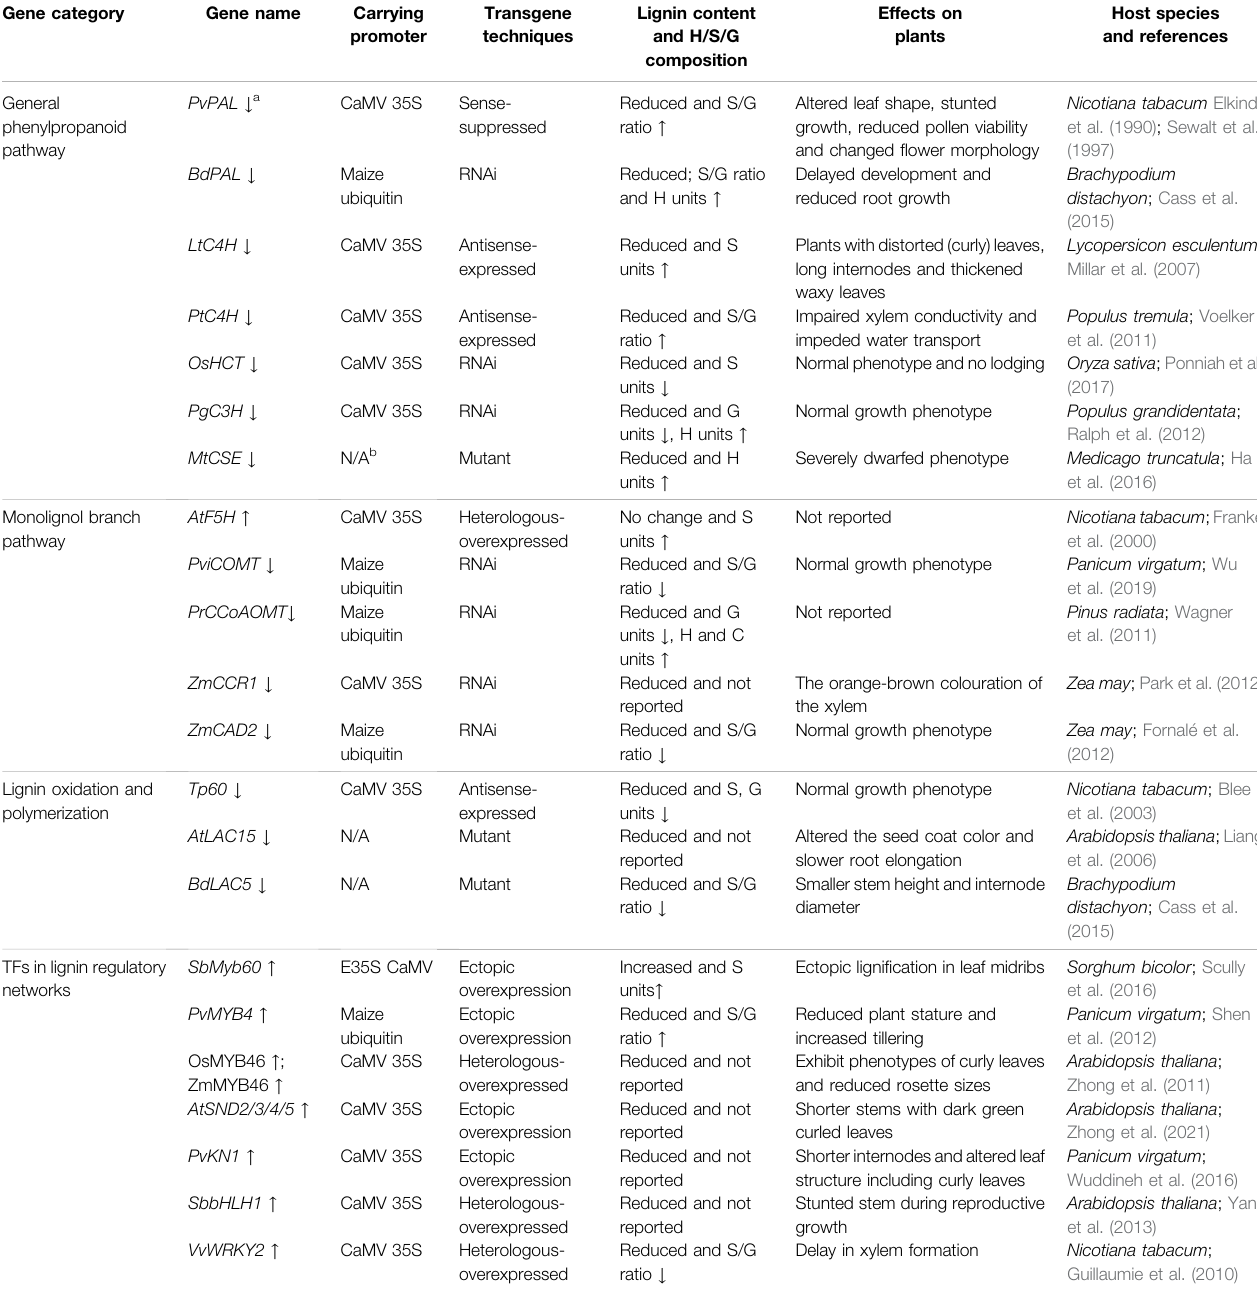
TABLE 1 | Common genetic modi fi cation of lignin biosynthesis in plants and its effects on plant growth and